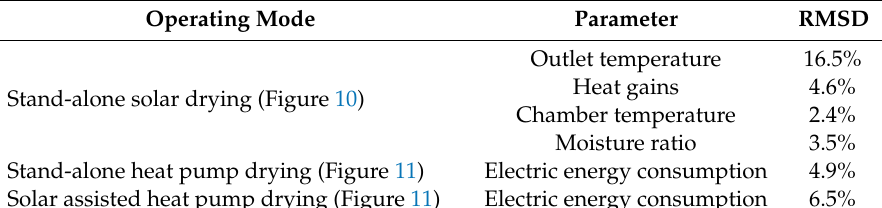
Table 5. Summary of the root mean square deviation between the simulation and experiment.